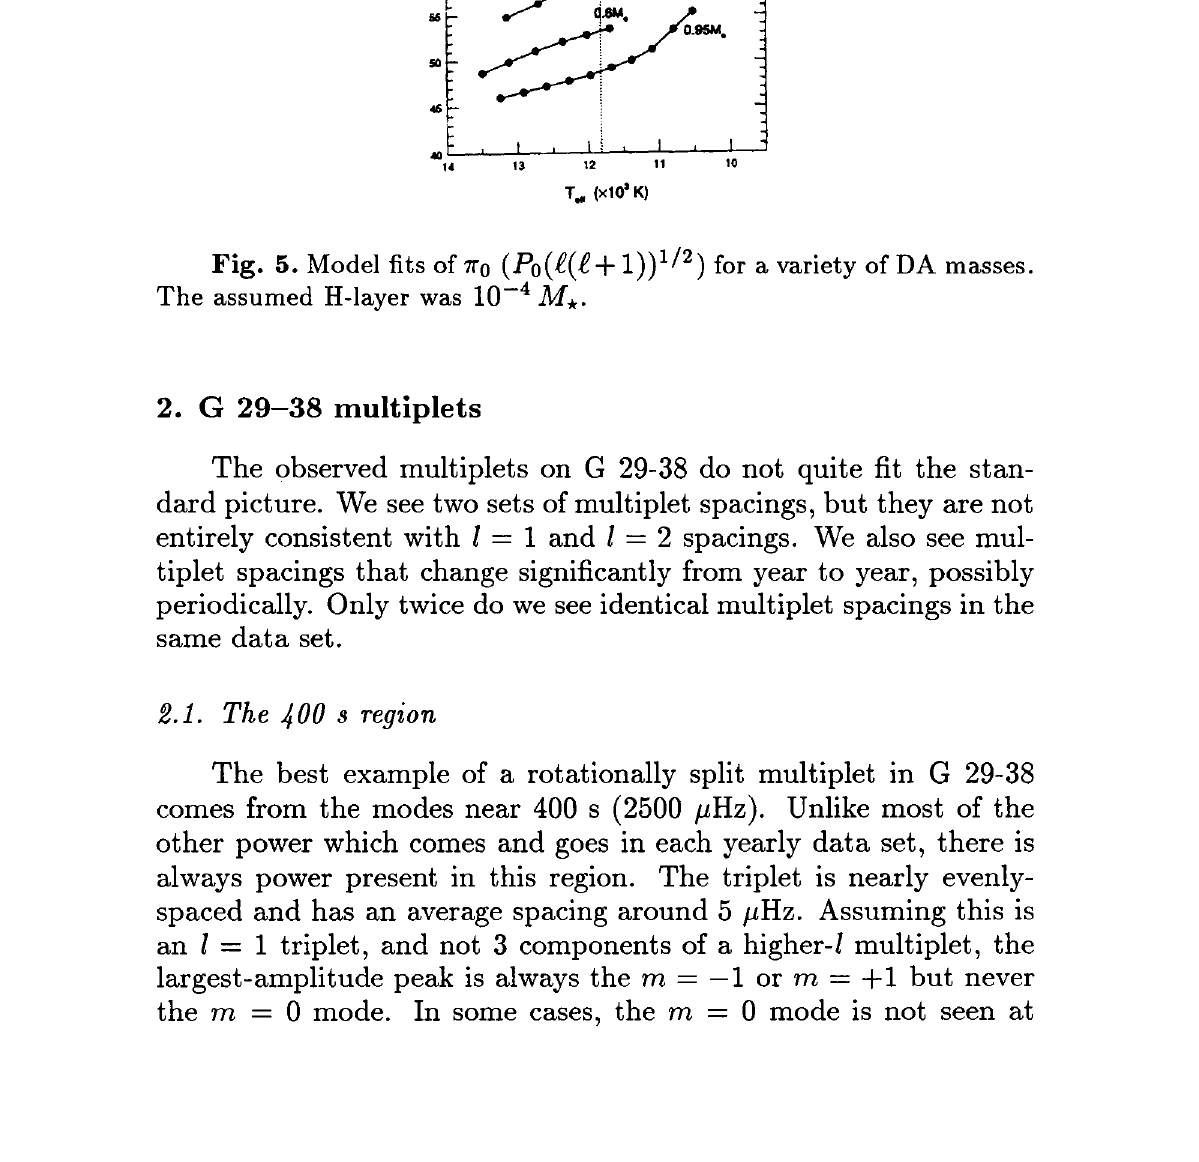
( P ( ^+ 1)) 1/2 ) for a variety of DA masses. 0 0